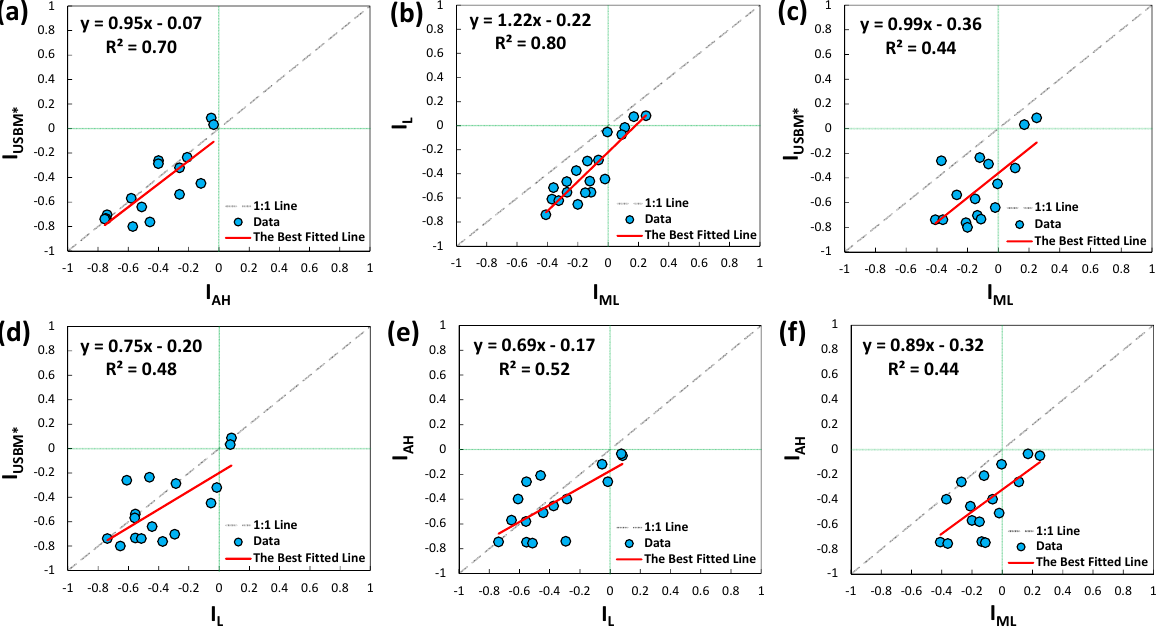
Figure 5. Correlations among different wettability indices calculated on core samples studied here.